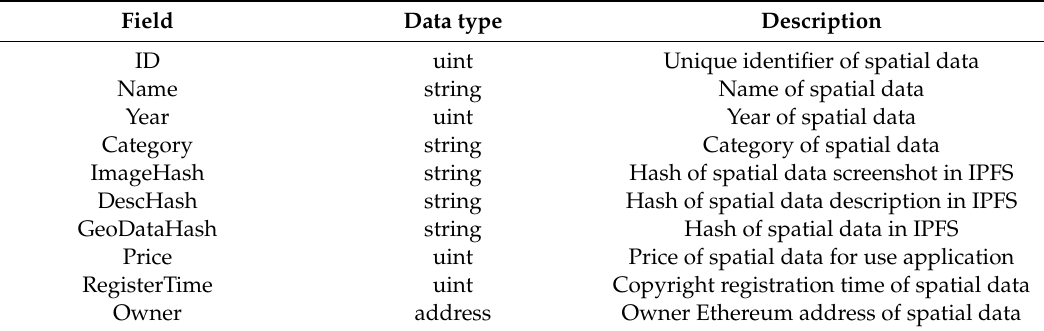
Table 2. Spatial data copyright information